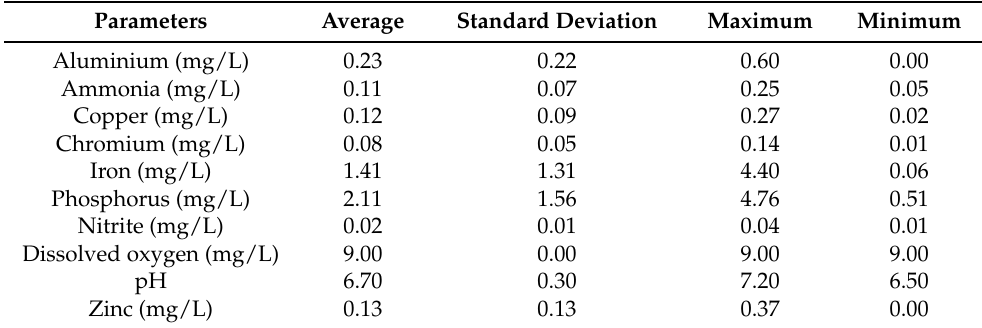
Table 7. Water quality for stormwater collected from the runoff of a paved road.